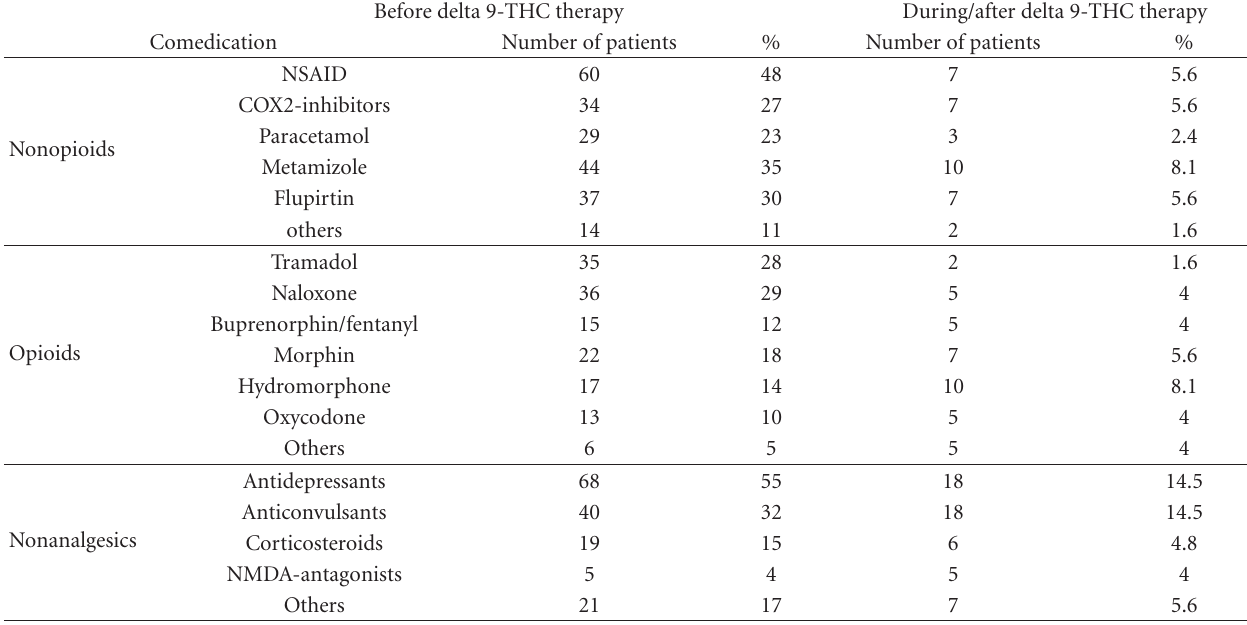
Table 2: Medication administered to the patients before and during/after delta 9-THC therapy. A substantial reduction of the medication within each group, that is, nonopioids, opioids, or nonanalgesics (primarily antidepressants and anticonvulsants), could be recorded during the treatment with delta 9-THC.